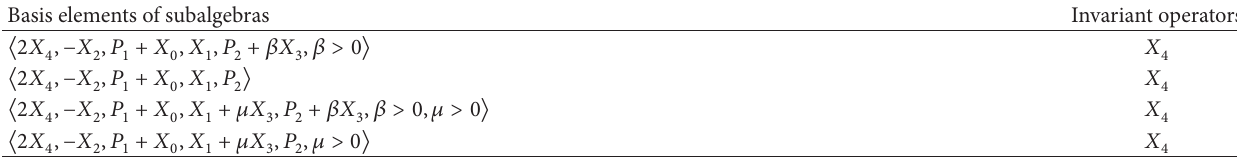
Table 18: Invariant operators of subalgebras of the type 𝐴 5,5 .